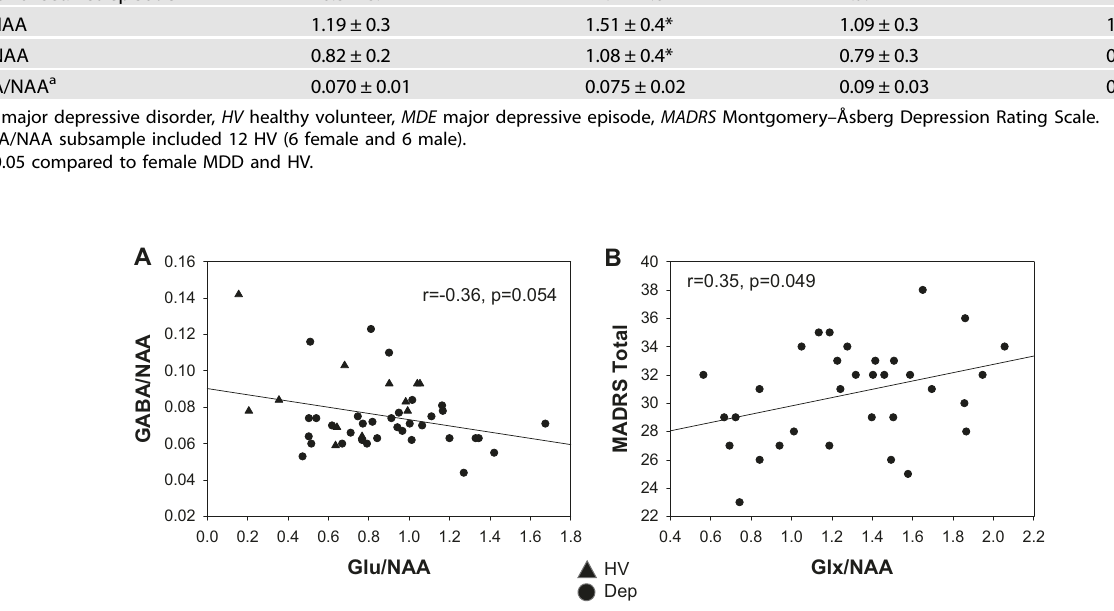
Fig. 1 Relationships between metabolites. A Scatter plots of Glu/NAA vs. GABA/NAA, B Glx/NAA vs. MADRS